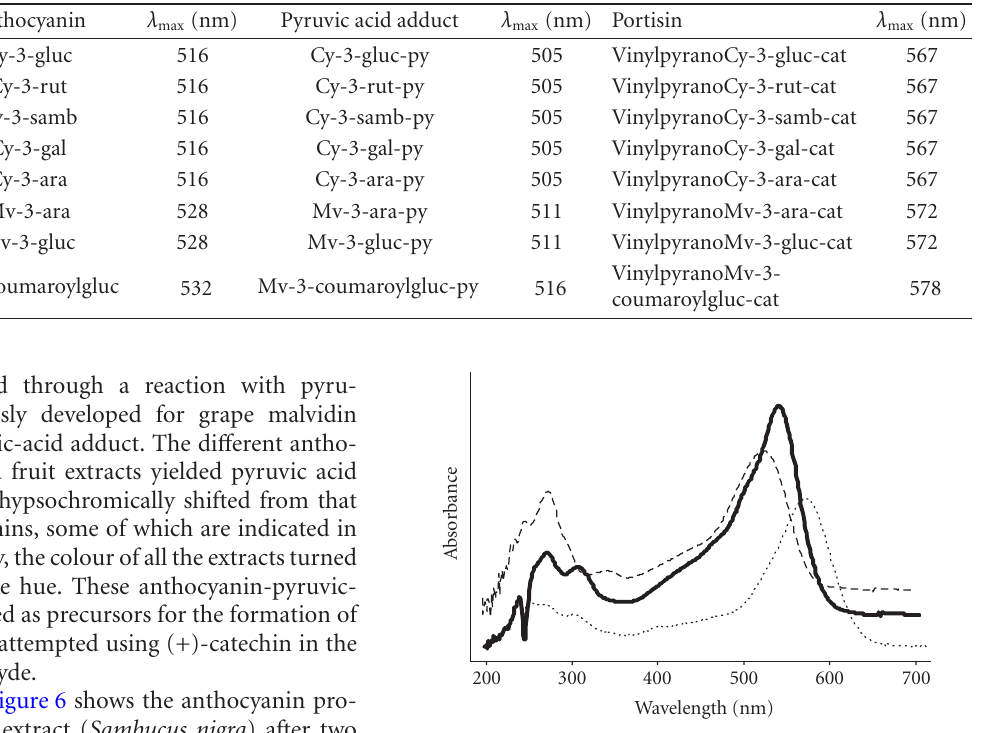
Table 3. Some anthocyanins respective pyruvic acid adducts and portisins obtained from di ff erent red fruit extracts. (Cy = cyanidin; Mv = malvidin; py = pyruvic acid derivative; gluc = glucoside; samb = sambubiose; ara = arabinose; rut = rutinose; cat = catechin.)